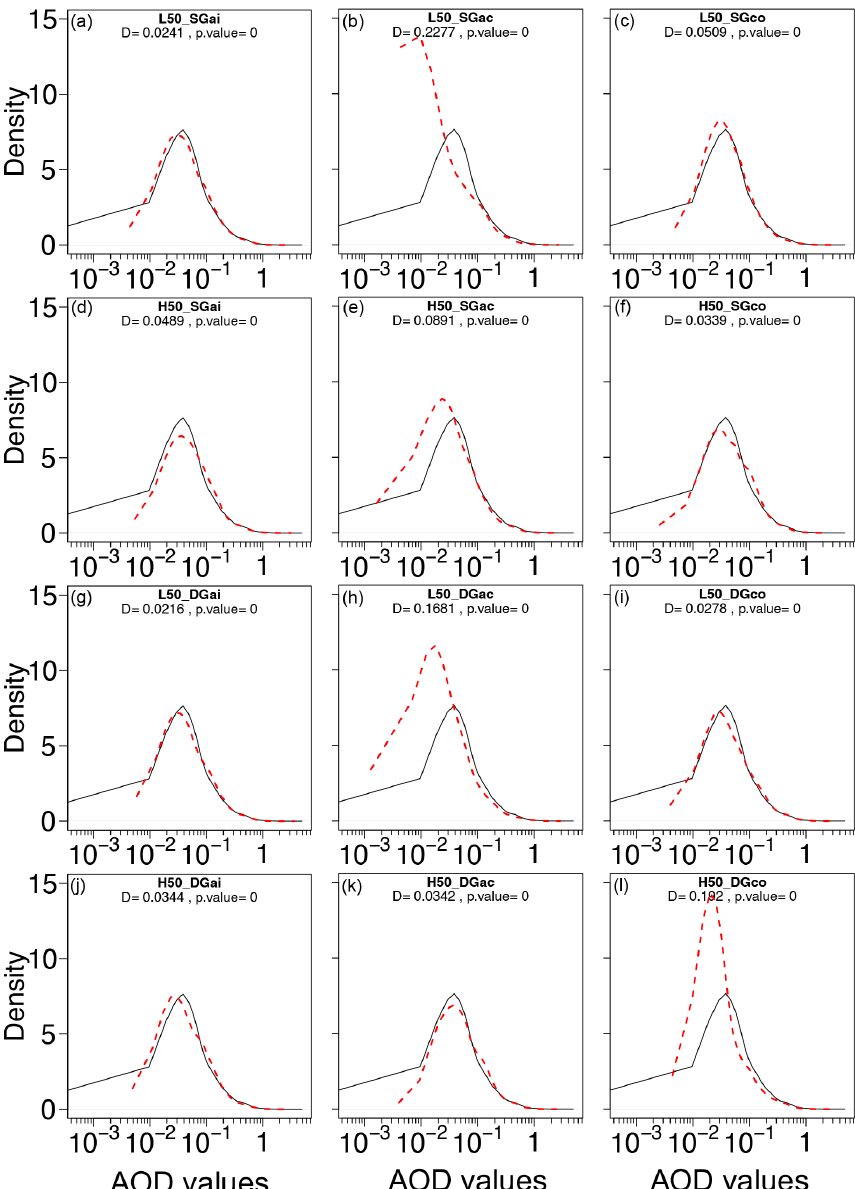
Figure 3. PDF of AOD values for the base case (black line) and each of the sensitivity test simulations at 50% (dashed red line). Values in figures represent the results of the statistics from the Kolmogorov–Smirnov test. (a) Aitken-mode 50% reduction in SG; (b) accumulation- mode 50% reduction in SG; (c) coarse-mode 50% reduction in SG; (d) Aitken-mode 50% increase in SG; (e) accumulation-mode 50% increase in SG; (f) coarse-mode 50% increase in SG; (g) Aitken-mode 50% reduction in DG; (h) accumulation-mode 50% reduction in DG; (i) coarse-mode 50% reduction in DG; (j) Aitken-mode 50% increase in DG; (k) accumulation-mode 50% increase in DG; (l) coarse-mode 50% increase in